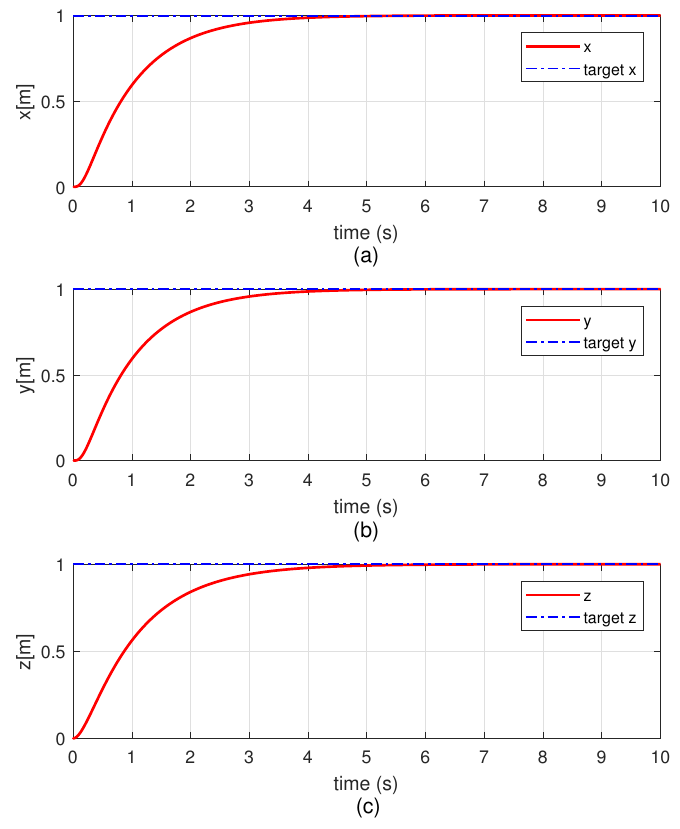
Figure 4. The position control results for each of the three axes. The dashed line indicates the goal position of each axis, and the solid line is the result of the simulation about each axis: ( a ) x ; ( b ) y ; ( c ) z